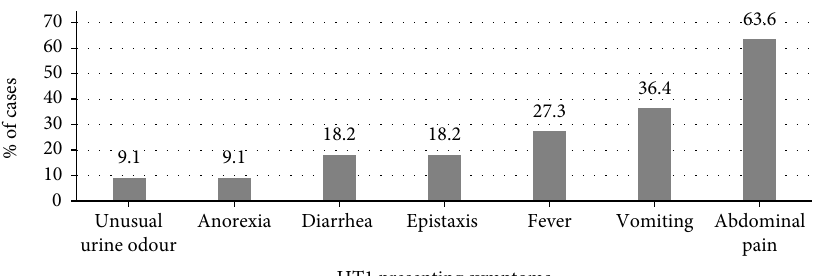
Figure 1: Presenting symptoms of the HT1.